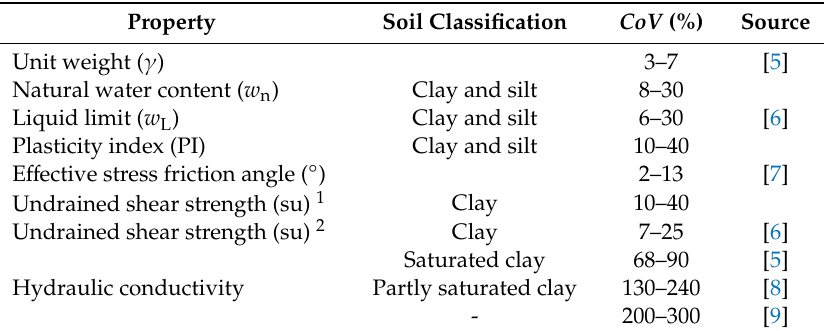
Table 1. Variation coe ffi cient of di ff erent soil